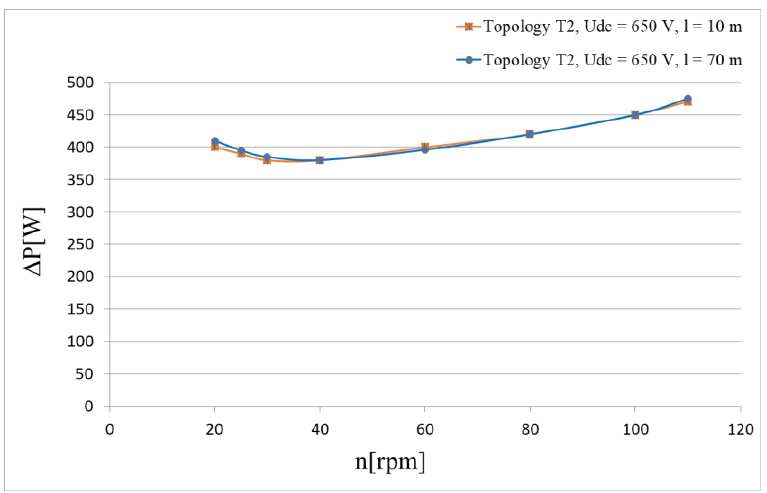
Figure 16. Power losses in converters of the topology T2 depending on the length of the cable connecting the generator and the converter.